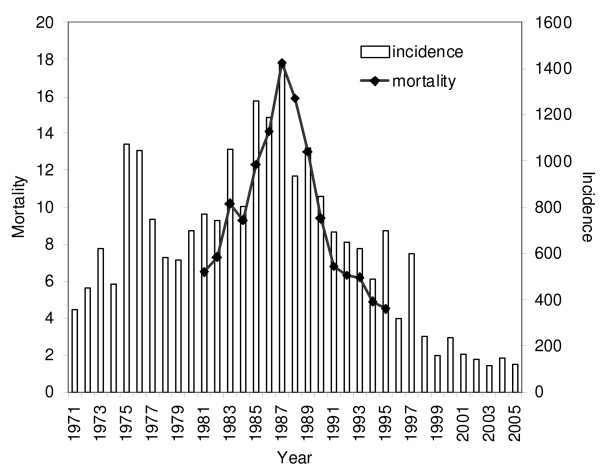
Acute viral hepatitis incidence (1971–2005) and associated mortality rates (1981–1995), by year, Uzbekistan (per 100,000 population). Left ordinate (y-axis) and line graph: mortality per 100,000 population. Right ordinate (y-axis) and bar diagram: reported acute viral hepatitis incidence per population.